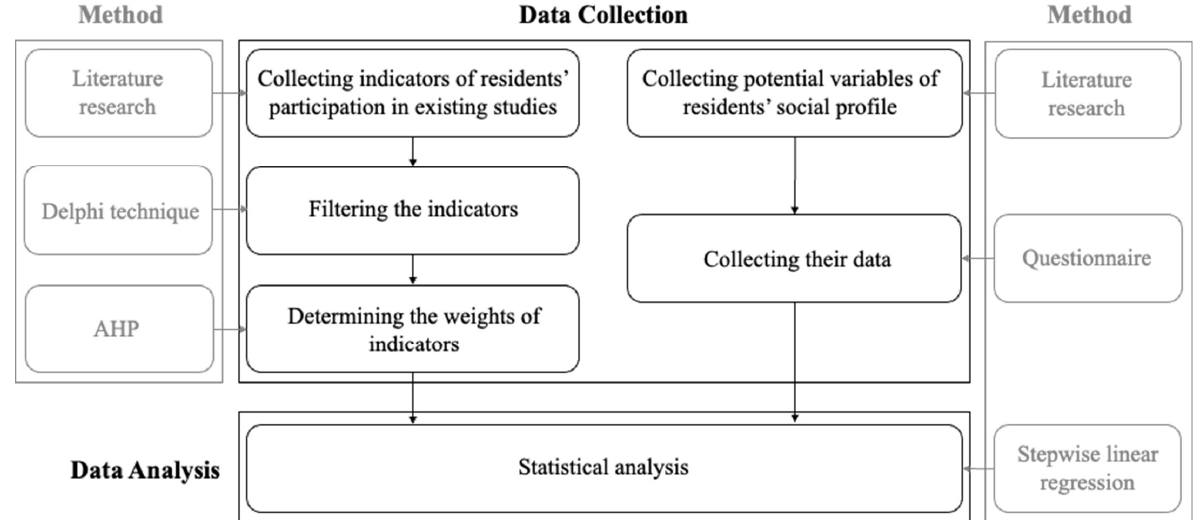
Figure 1. Methodological framework (Source: Compiled by the researcher).